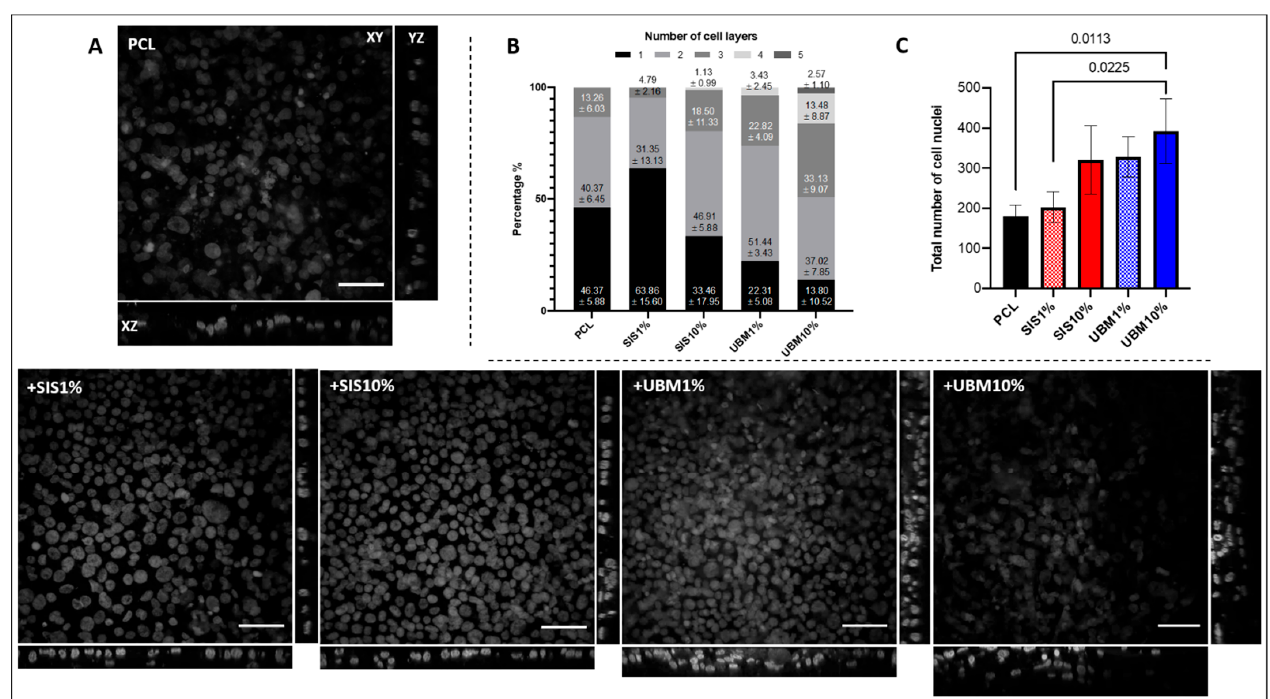
Figure 7. Representative scanning electron microscopy images of human conjunctival epithelial cells cultured on electro- spun scaffolds fabricated from poly( ε -caprolactone) (PCL) and PCL with addition of 1% or 10% decellularised tissue pow- der (small intestinal submucosa (SIS) and urinary bladder matrix (UBM)). Images: top row = ×1000 (scale = 50 µm), middle row = ×5000 (scale = 10 µm), bottom row = ×10,000 (scale = 5 µm); arrows indicate presence of microvilli.